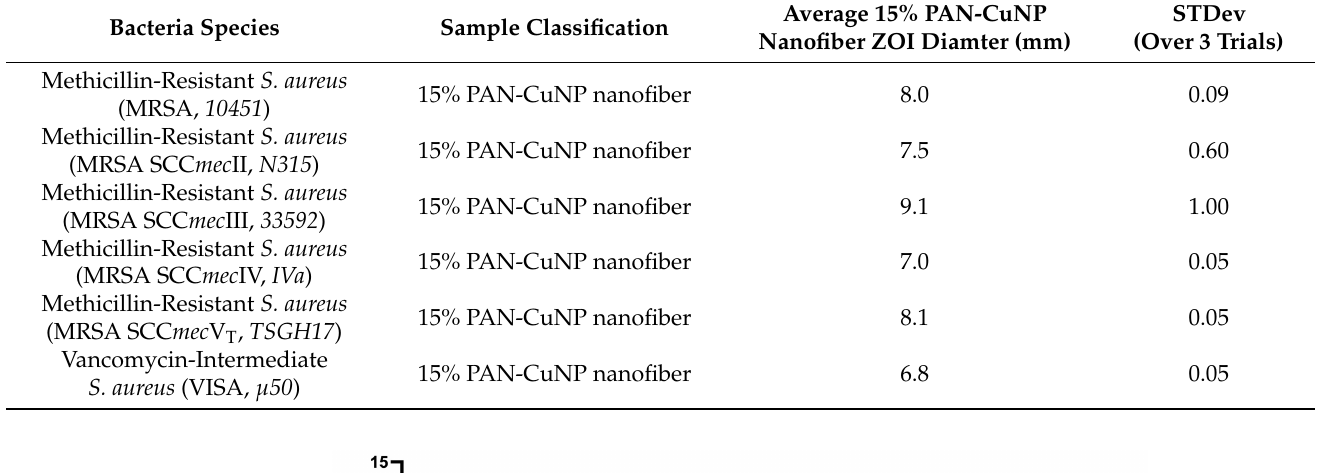
Table 5. Antibacterial Efficiency of 15% PAN-CuNP Nanofibers on Various MRSA and VISA Strains.